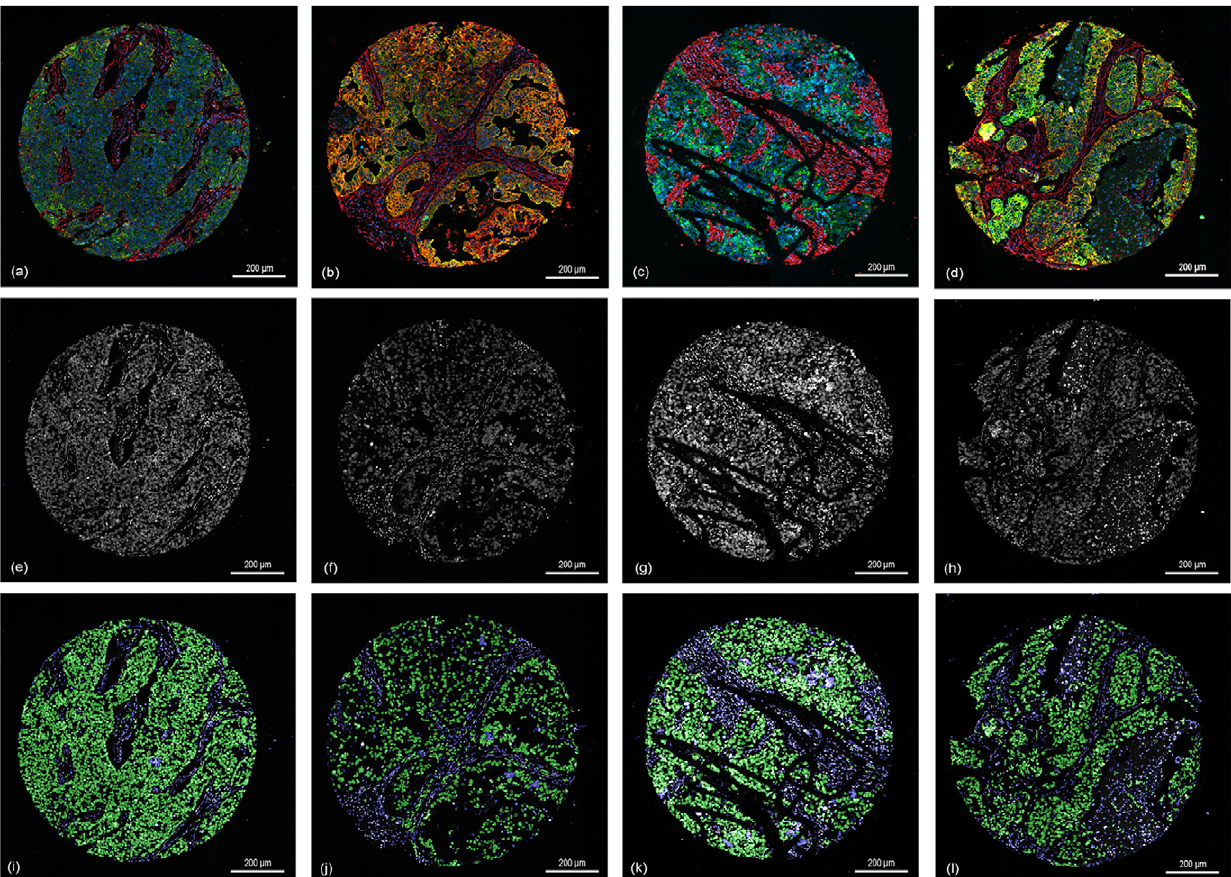
Figure 5. The results of the classification. (a–d) showing the original RGB core images; (e–h) showing the corresponding DAPI channel as an intensity image of the cores (a–d); (i–l) results of the classification step, green=cells classified as tumor cells, blue=cells classified as stroma cells.